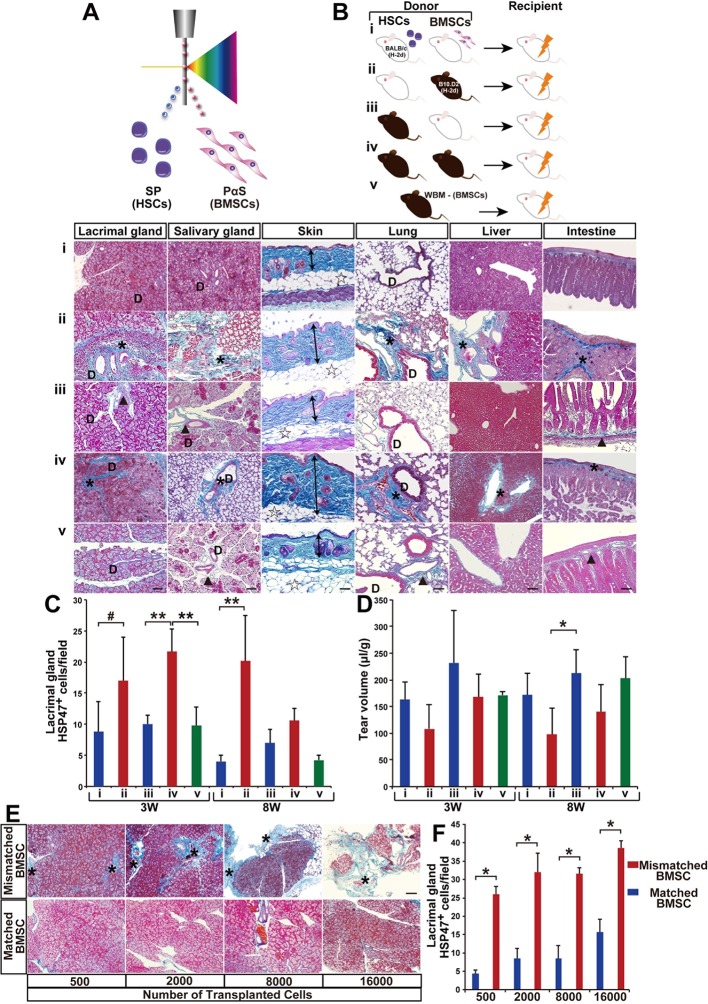
Modified SSc model by co-transplanting isolated HSCs and BMSCs.(A, B) Transplantation model with different combinations of syngeneic (white) and mismatched (black) HSCs and BMSCs co-transplanted into BALB/c mice. (B, i–v) (i) Negative control, (ii) mismatched BMSC transplantation, (iii) syngeneic BMSC transplantation, (iv) positive control, and (v) mismatched MSC-depleted WBMT. Excessive fibrosis (deep blue, and ∗) in various organs was observed in mismatched BMSC transplanted mice after 3 weeks. Double arrows indicate epidermal and dermal thickness. The fibrotic areas were assessed as the ratio of the blue-stained area per field. D, duct. Minimal Mallory staining areas (▲) in (iii) and (v) are physiological changes and necessary to support the structure of ducts and intestinal walls. Scale bar, 100 μm (50 μm in liver). (C) HSP47+ fibroblasts in the lacrimal glands were significantly higher following mismatched BMSC transplantation (red) compared to syngeneic BMSC (blue), and BMSC-depleted WBM transplantation (green). The number of HSP47+ cells in negative control (i) (blue), and syngeneic MSC transplantation (iii) (blue), and mismatched MSC transplantation (ii) (red), and positive control (iv) (red), and mismatched MSC-depleted WBMT (green). Data are shown as mean ± SD, #p<0.05, *p<0.01, **p<0.001. (D) Tear volume in the same groups described in (C). Data are shown as mean ± SD, n = 2-5 per group, *p<0.05. (E, F) The degree of fibrosis (blue) in the lacrimal glands of mismatched BMSC recipients was dose dependent. Excessive fibrotic areas are shown in deep blue (∗). Data are shown as mean ± SD, n = 3. Scale bar, 100 μm. *p<0.001. BMSCs, bone marrow stromal/stem cells; HSCs, hematopoietic stem cells; SD, standard deviation.DOI:
http://dx.doi.org/10.7554/eLife.09394.00310.7554/eLife.09394.004Figure 1—source data 1.HSP47+ cells/ field in the lacrimal glands.Number of HSP47+ cells per field (x200) from 5 to 13 areas from the lacrimal glands 3 and 8 weeks following transplantation. Source data for (C). HSP, heat-shock protein.DOI:
http://dx.doi.org/10.7554/eLife.09394.00410.7554/eLife.09394.005Figure 1—source data 2.Tear volume following transplantation.Source data for graph shown in (D).DOI:
http://dx.doi.org/10.7554/eLife.09394.00510.7554/eLife.09394.006Figure 1—source data 3.The number of HSP47+ cells/field in the lacrimal glands after transplantation of 500, 2000, 8000, and 16,000 syngeneic or mismatched BMSCs shown in (F). HSP, heat-shock protein.DOI:
http://dx.doi.org/10.7554/eLife.09394.00610.7554/eLife.09394.007Figure 1—source data 4.Number of HSP47+ cells/ field from in various target organs after whole bone marrow transplantation.Number of HSP47+ cells per field from 4 to 5 areas in each organ 3 and 8 weeks following WBM for Figure 1—figure supplement 1(C). HSP, heat-shock protein.DOI:
http://dx.doi.org/10.7554/eLife.09394.00710.7554/eLife.09394.008Figure 1—source data 5.HSP47+ cells per field in the salivary gland, skin, lung, liver, and intestine shown in Figure 1—figure supplement 3B.Data for each organ are displayed on separate sheets.